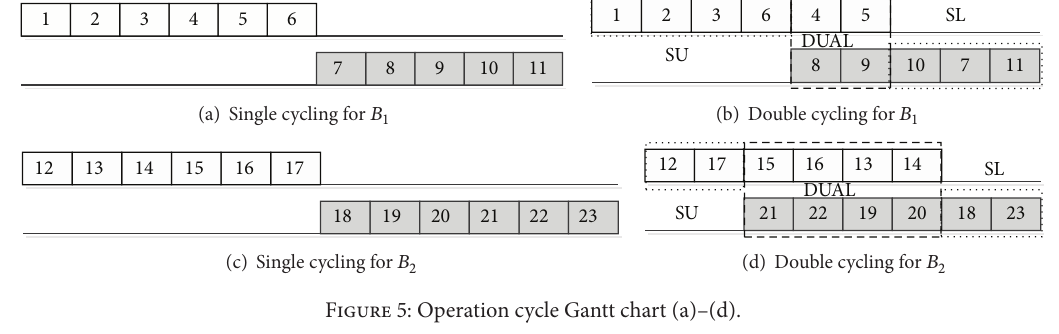
Figure 5: Operation cycle Gantt chart (a)–(d).